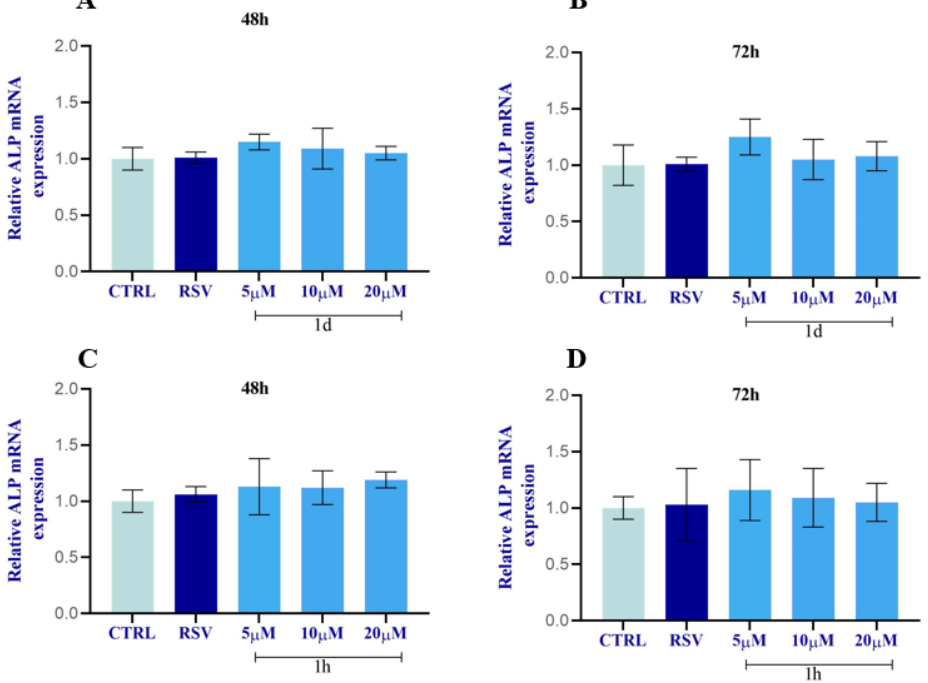
Figure 16. Effects of 1d ( A , B ) and 1h ( C , D ) on ALP expression at 48 h and 72 h. The histograms represent normalized data for the housekeeping β ACT. The values represent the average of three independent experiments with the relative SD (Error bars).